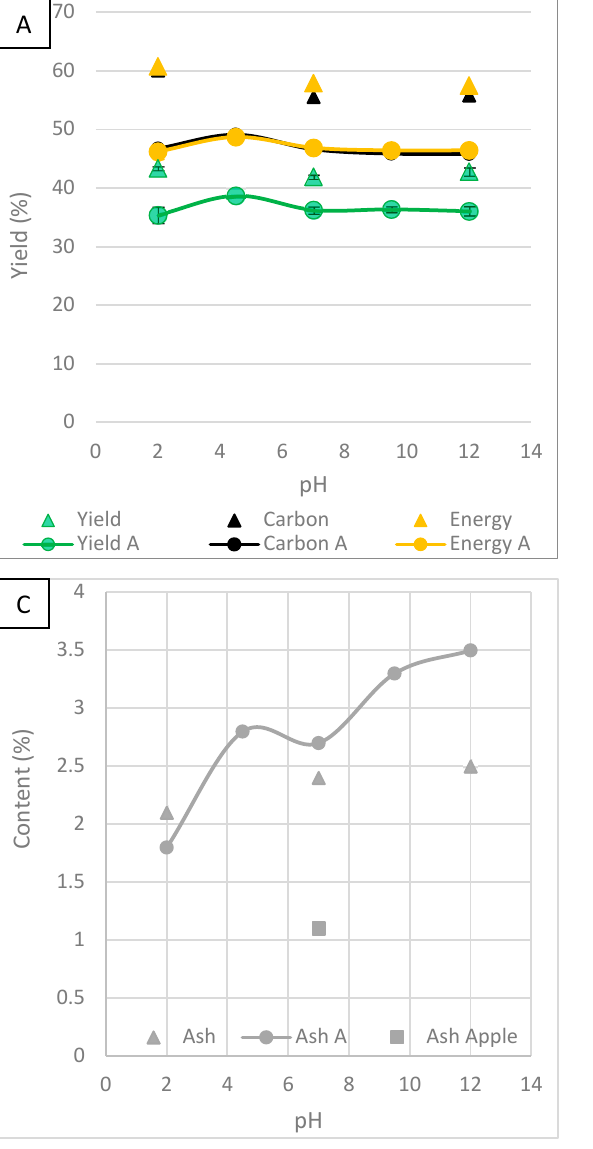
Figure 9. The effect of solution pH and washing with acetone on ( A ) yield, carbon recovery and energy yield, ( B ) carbon and oxygen content, ( C ) ash content and ( D ) HHV.